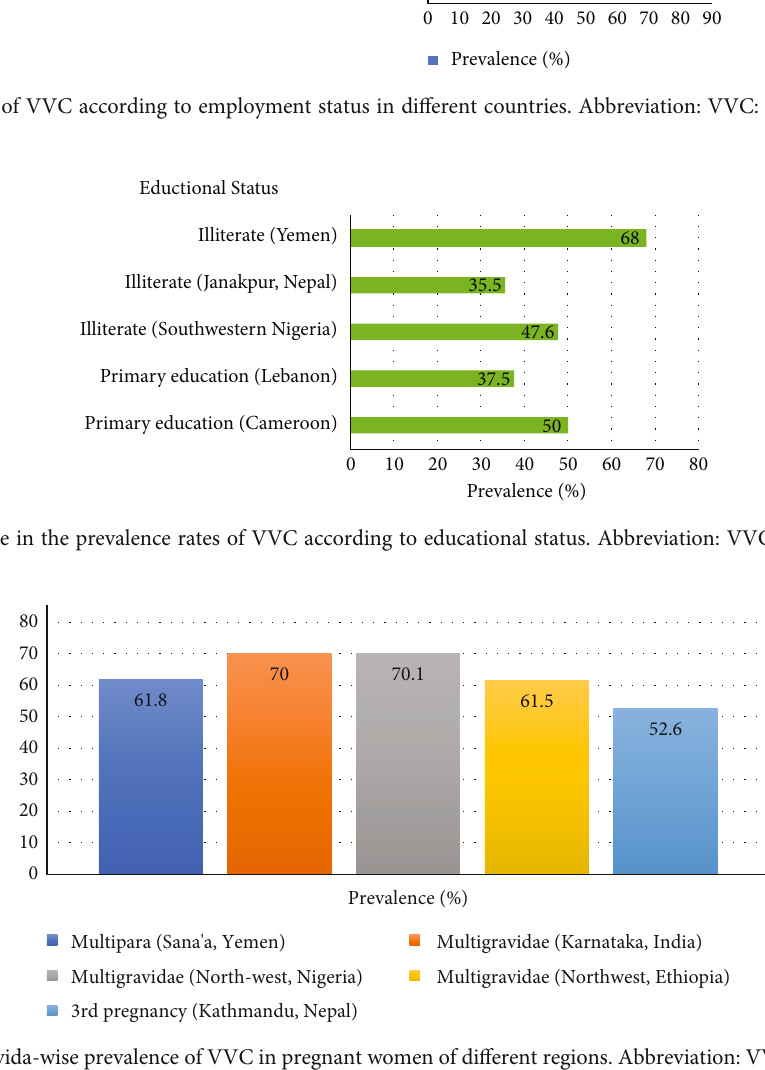
Figure 5: Parity- and gravida-wise prevalence of VVC in pregnant women of di ff erent regions. Abbreviation: VVC: vulvovaginal